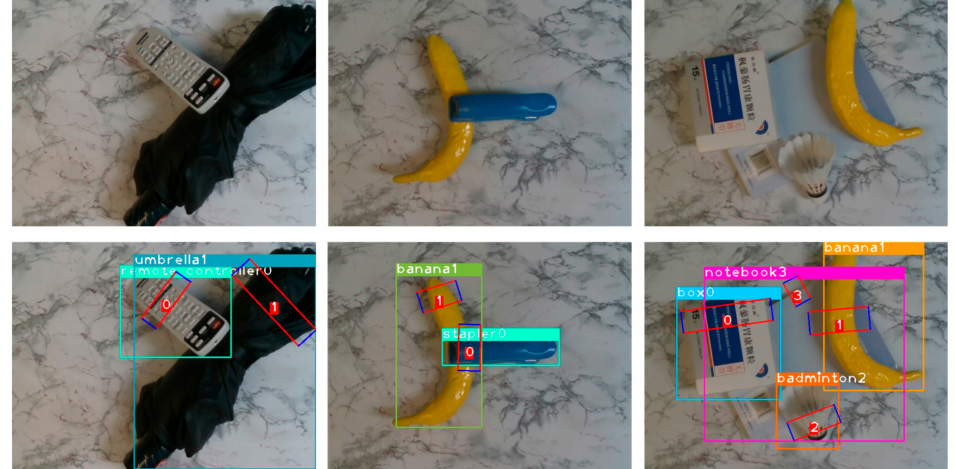
Figure 7. First test set sample. The three images above are the original images from the its and the following are the results of the